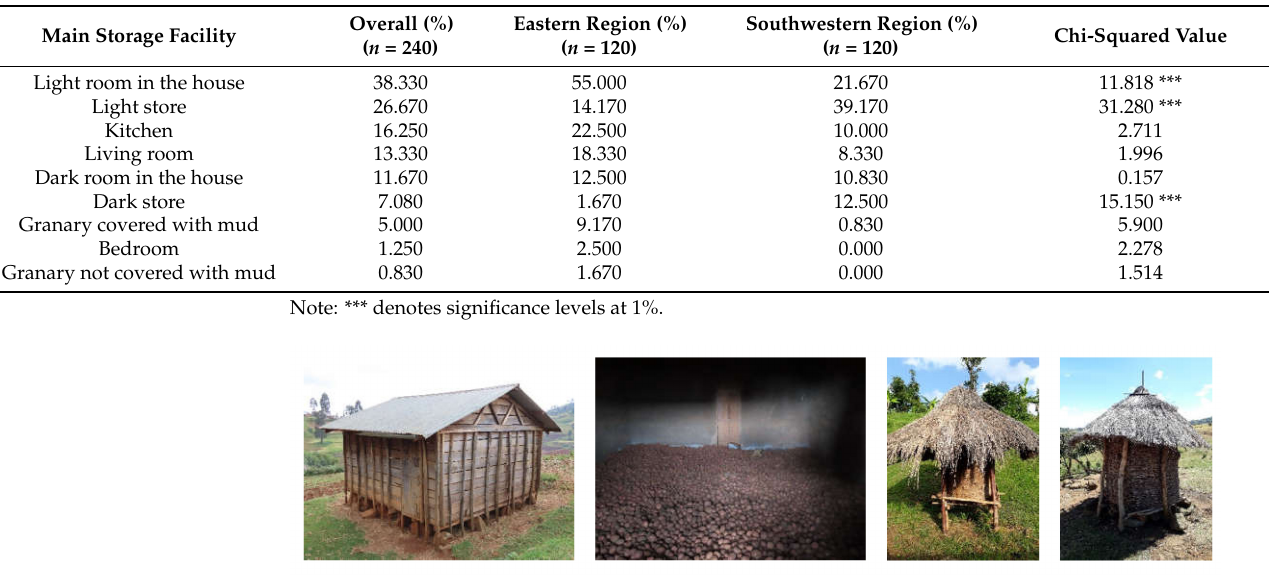
Figure 1. Traditional storage facilities used by potato farmers in eastern and southwestern Uganda (from left to right: light store, dark store, granary covered with mud, granary not covered with mud) (Credit: CIP/P.